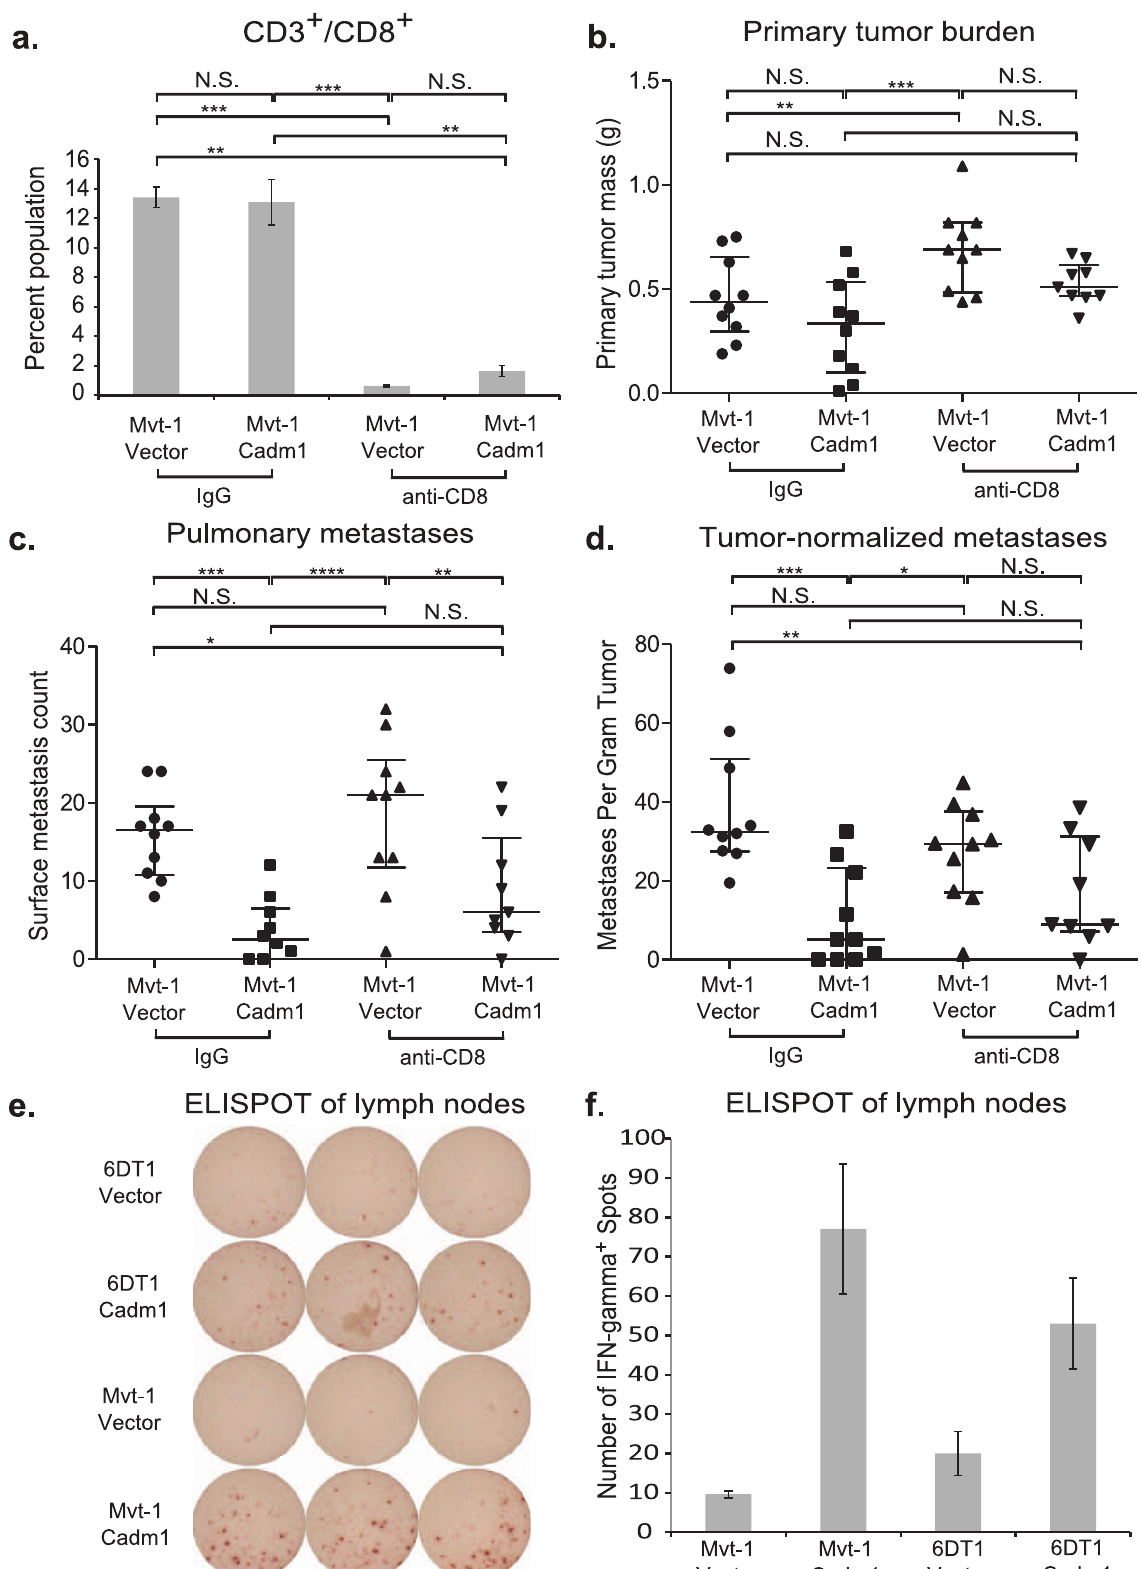
Figure 6. The effect of Cadm1 expression on tumor and metastasis in CD8 + T cell depleted mice. Orthotopic injections of control and Cadm1 -expressing Mvt-1 cells into immune-competent FVB mice that were treated with IgG or anti-CD8 resulted in (a) . 90% depletion of CD8 + T cells. (b) No significant differences were observed in tumor burden between control and Cadm1 expressing within the same antibody treatment